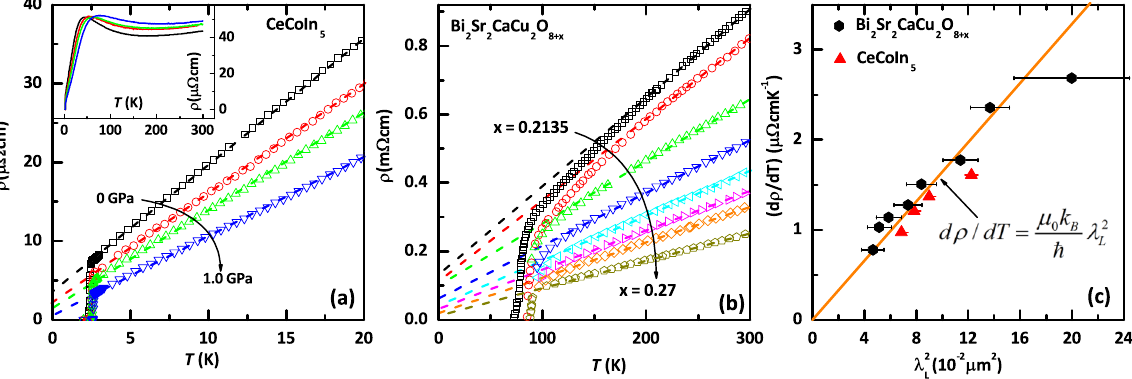
Figure 1. ( a ) T dependent resistivity ρ of CeCoIn 5 under the pressure 0, 0.3, 0.55, 1.0 GPa. The arrow points to the increase in pressures. Inset to 1( a ) is the ρ of CeCoIn 5 up to 300 K. ( b ) T dependent resistivity ρ of oxygen doped Bi 2 Sr 2 CaCu 2 O 8 + x with x = 0.2135, 0.217, 0.22, 0.24, 0.245, 0.255, 0.26, 0.27, respectively. The arrow points to the Bi2212 from underdoped to overdoped. The resistivity data of Bi 2 Sr 2 CaCu 2 O 8 + x are taken 2 for CeCoIn from the literature 22 . ( c ) Linear scale plot of d ρ / dT vs. λ 5 (red triangles) and Bi 2 Sr 2 CaCu 2 O 8 + x L (Bi2212) (black circles). d ρ / dT is the slope of linear-temperature-dependent resistivity, and λ L is the London penetration depth of superconductors at zero temperature. The straight line corresponds to 2  , where ρ is in the unit of μ Ω cm , λ μ m , and T is in K. See Table 1 for details, ρ µ λ = d dT k / / ) L is in B L 0 including